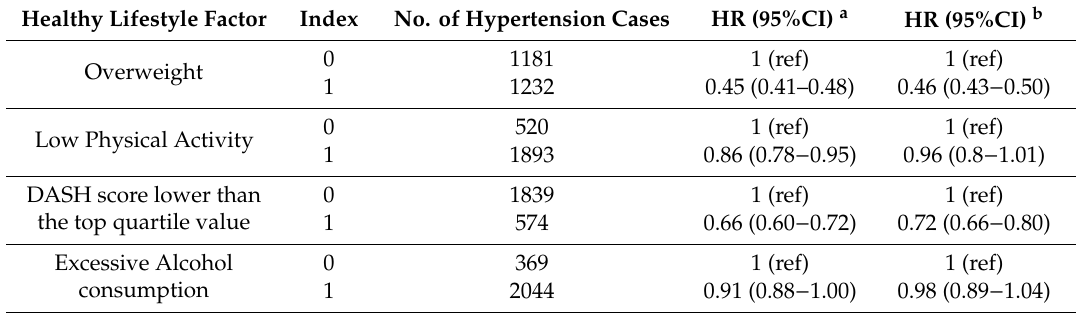
Table 3. Hazard ratios of incident hypertension in relation to individual lifestyle factors.